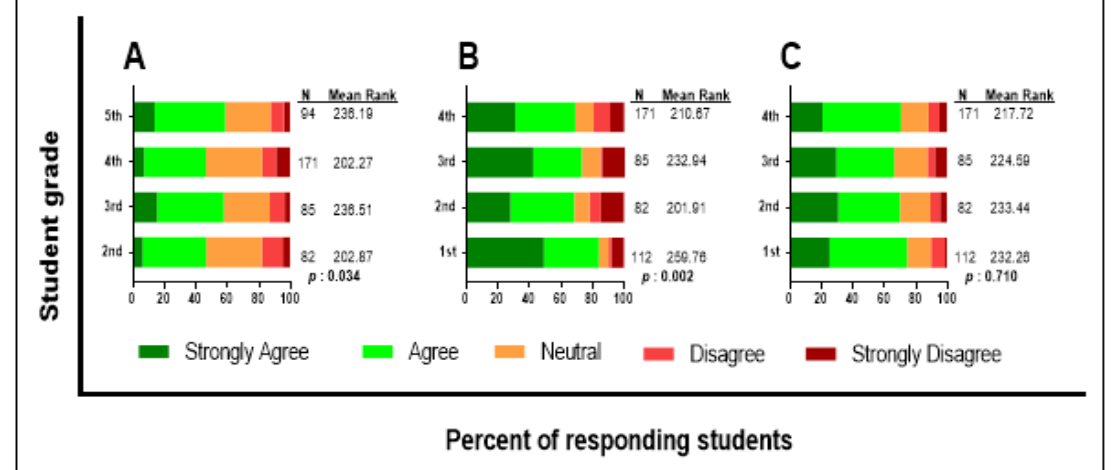
Figure 4. Student perceptions of the overall college performance in distance education and their